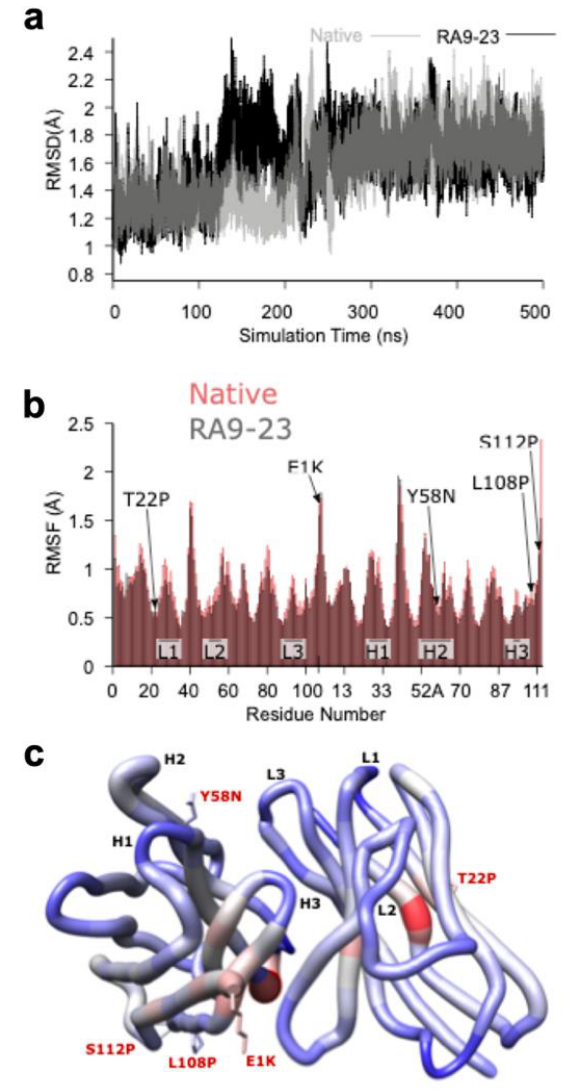
Figure 6. Molecular Modeling of the Fv Domain. ( a ) The root-mean-square deviation (RMSD) plot of the C α atoms of both the native (grey) and RA9-23 mutant (black) clones structures over the course of the 500 ns molecular dynamics (MD) simulations, showing a structural rearrangement occurring between ~140 and 250 ns for RA9-23, and between ~200 and 250 ns for native. ( b ) A per-residue C α atom root-mean-squared fluctuation (RMSF) plot for native (red) and RA9-23 (grey) clones. The plotted values are averages from five, 100 ns MD simulations that were started using 3D structures taken from the last 100 ns of the initial 500 ns simulation. The mutants and Complementarity Determining Regions (CDRs) are indicated. Most residues have lower RMSF values in the RA9-23 structure versus native (0.75 ± 0.05 versus 0.82 ± 0.03; p = 0.0277, n = 5, t -test). ( c ) A “worm” plot of the di ff erences in C α atom RMSF values between native and RA9-23 clones residues. The color range is from − 0.3 (blue, more stable in RA9-23) to 0.0 (grey, no di ff erence) to + 0.3 (red, less stable in RA9-23). The sidechains are shown for residues that are mutated in RA9-23 versus native. *** p < 0.005